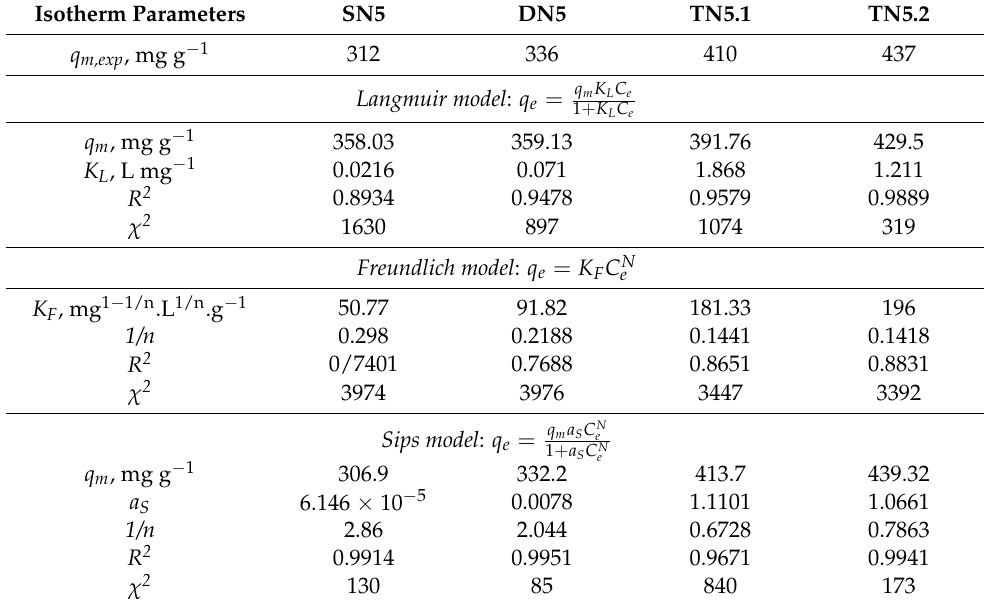
Table 3. Isotherm parameters for the sorption of Cr 2 O 72 − anions onto SN5 cryogels and derived composite